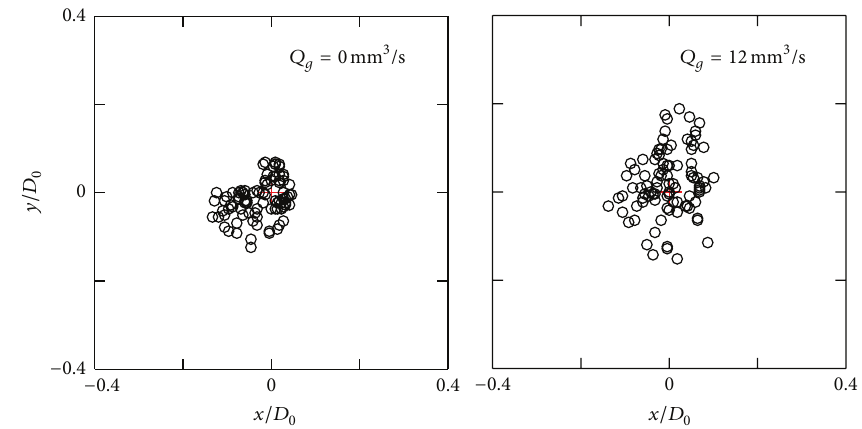
Figure 16: Locus for the upper end of vortex core when Ω = 7.9 × 10 4 .